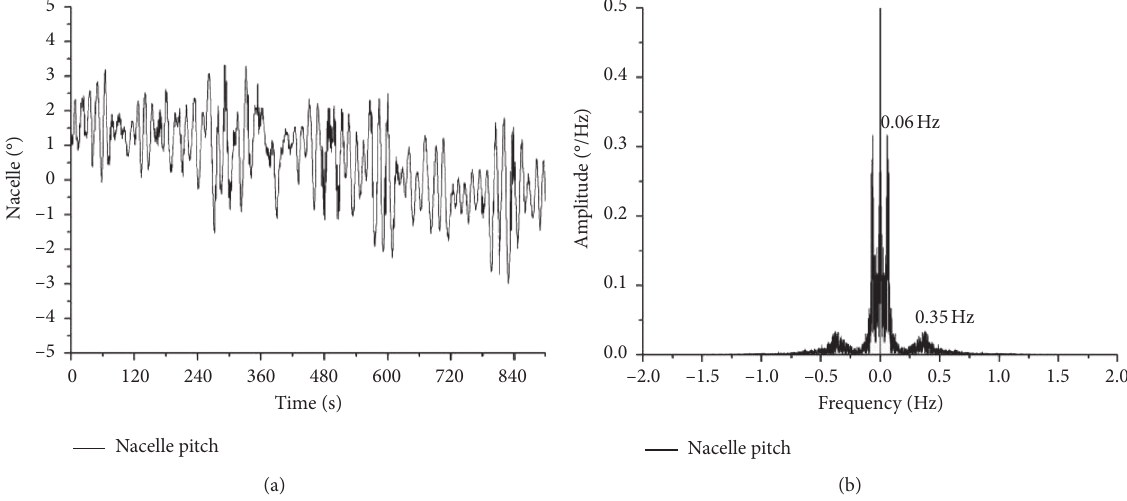
Figure 11: (a) Hot-air balloon basket pitch angle change. (b) Hot-air balloon basket pitch spectrum change.